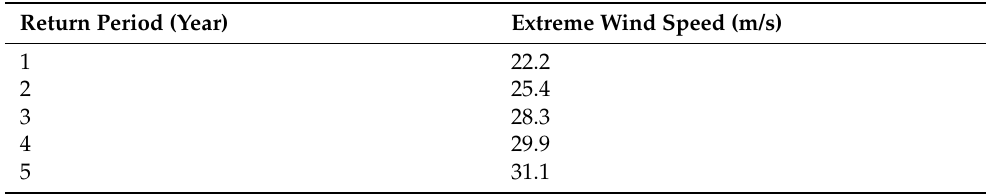
Table 5. Extreme wind speeds in the most unfavorable wind direction (D2) corresponding to different return periods in